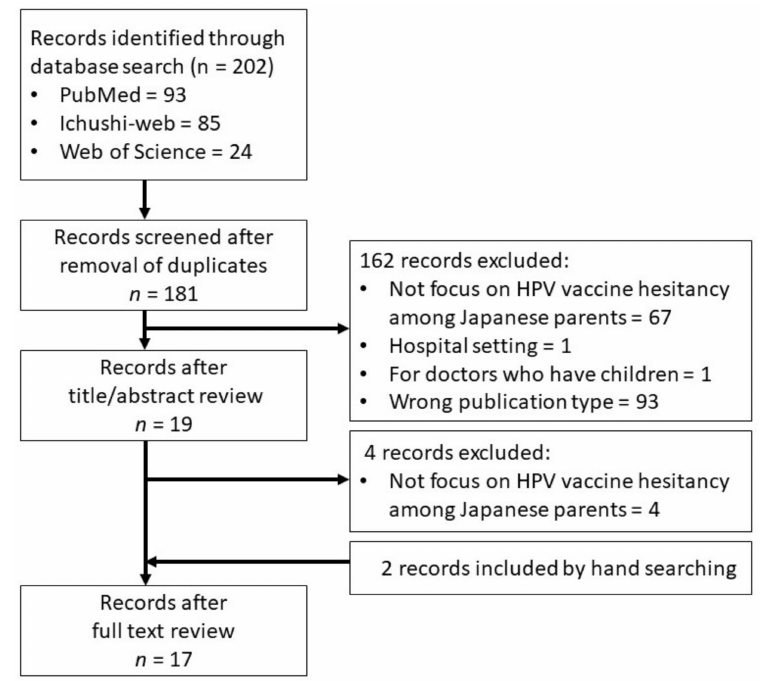
Figure 1. Flowchart of the selection